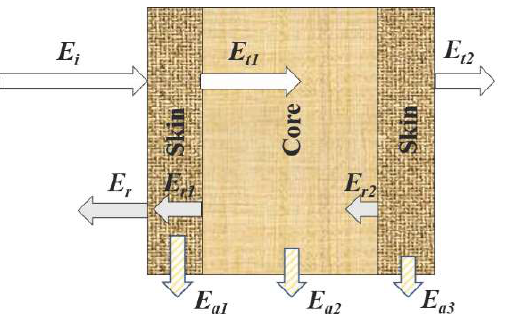
Figure 11. Schematic diagram of sound energy absorption mechanism for sandwich structure.